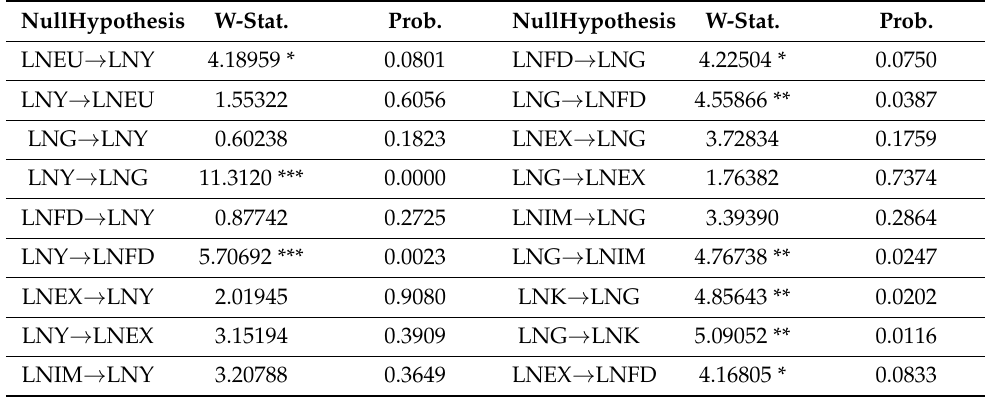
Table 8. The Results of Dumitrescu–Hurlin Panel Causality